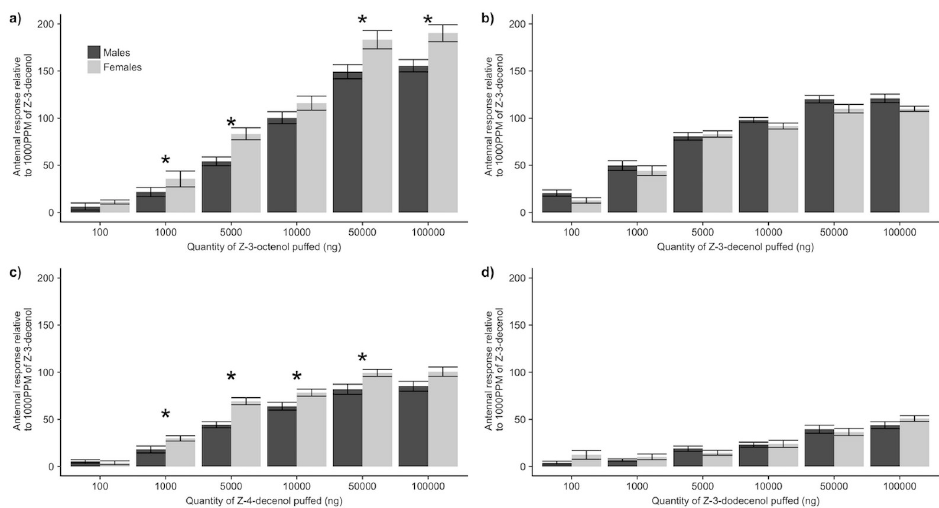
Fig 2. Electro-antennogram dose-response profiles of four compounds found in male effluvia. Relative EAG responses (mean ± SE) of a) ( Z )-3-octenol, b) ( Z )-3-decenol, c) ( Z )-4-decenol and d) ( Z )-3-dodecenol puffed on male (black, n = 10) and female (grey, n = 10) S . noctilio antennae for six different doses tested. Asterisk indicates significant differences (p < 0.05) between male and female for the same dose puffed.